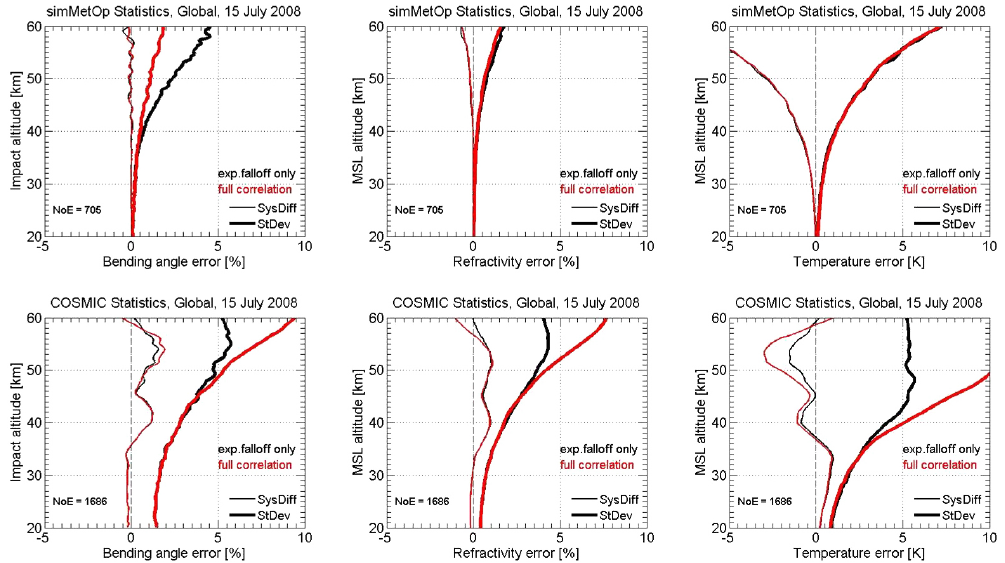
Figure 15. Bending angle (left), refractivity (middle), and temperature (right) systematic differences (SysDiff, light lines) and standard deviations (SD, heavy lines), relative to their “perfect simulated” or co-located ECMWF analysis data used as a reference, of the global ensemble of simMetOp (top) and COSMIC (bottom) events from 15 July 2008, using either the realistic global-mean correlation matrix of the new dynamic method (“full correlation”) or simple exponential fall-off correlation as in the existing OPSv5.6 (“exp.falloff only”). The number of events (NoE) in each statistical ensemble is also indicated in the